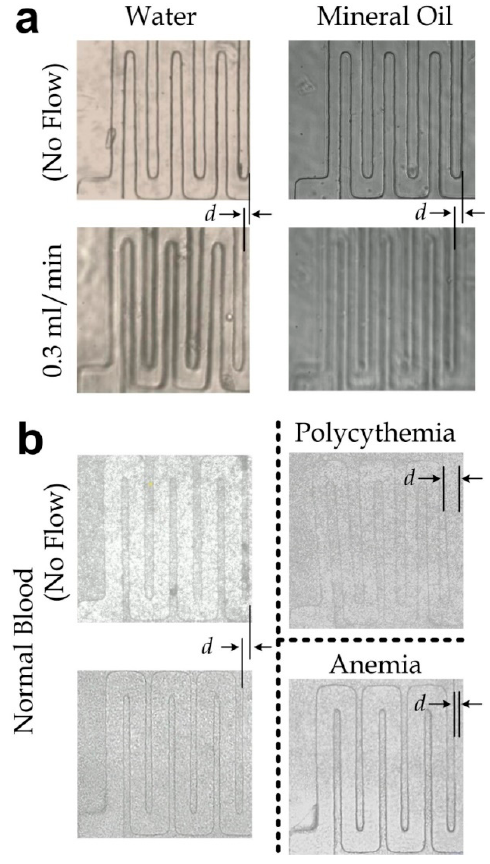
Figure A2. ( a ) Microscopic images of membrane displacements without and with the flow of water and mineral oil. The flow rate was chosen as 0.3 mL/min for both liquids for comparison. ( b ) Membrane displacements under flows (0.3 mL/min) of blood samples with different hematocrit conditions (anemia, normal, and polycythemia).